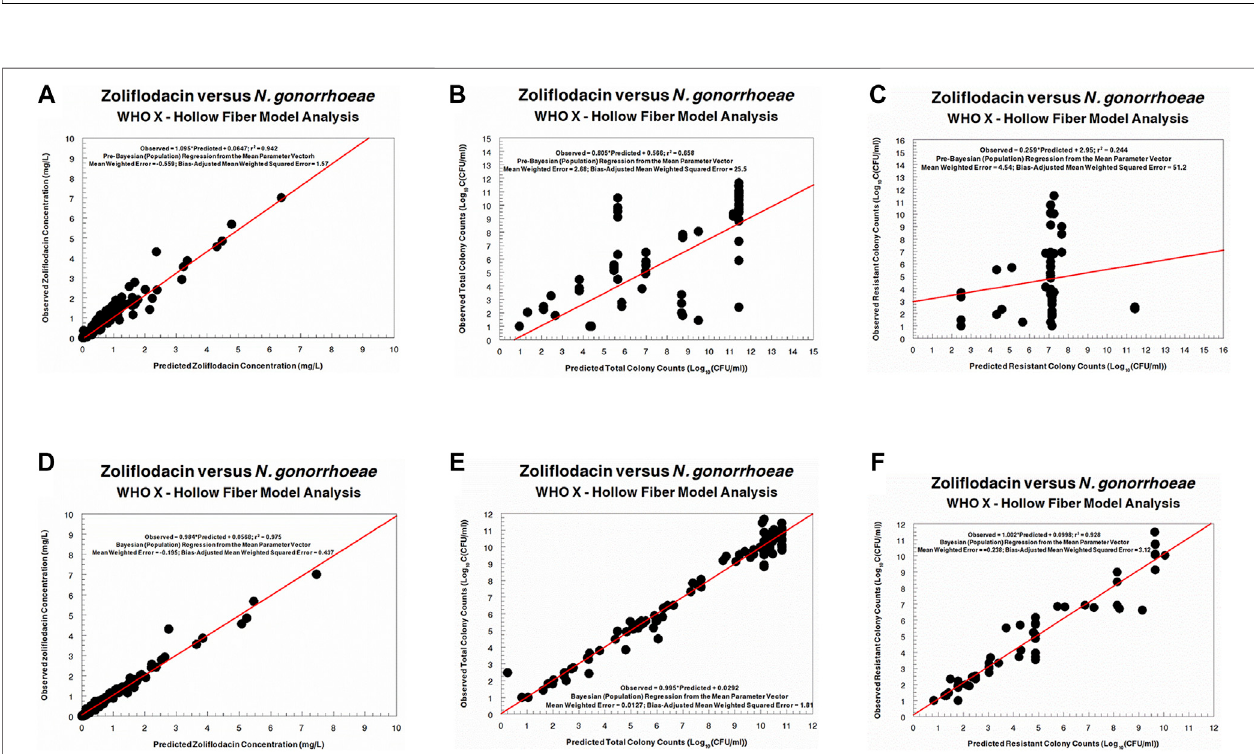
FIGURE4| Predicted-observed regressions forzoli fl odacin concentrations,total Neisseria gonorrhoeae burden,and resistant N. gonorrhoeae burden forthepre- Bayesian regression (A – C) and for the Bayesian regressions (D – F) for WHO X.